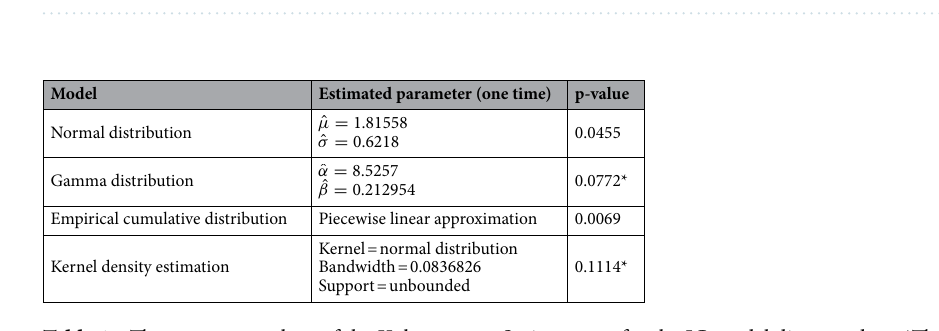
Table 1. The average p-values of the Kolmogorov–Smirnov test for the JC model distance data. *The p-values greater than 0.05 are denoted as asterisk.